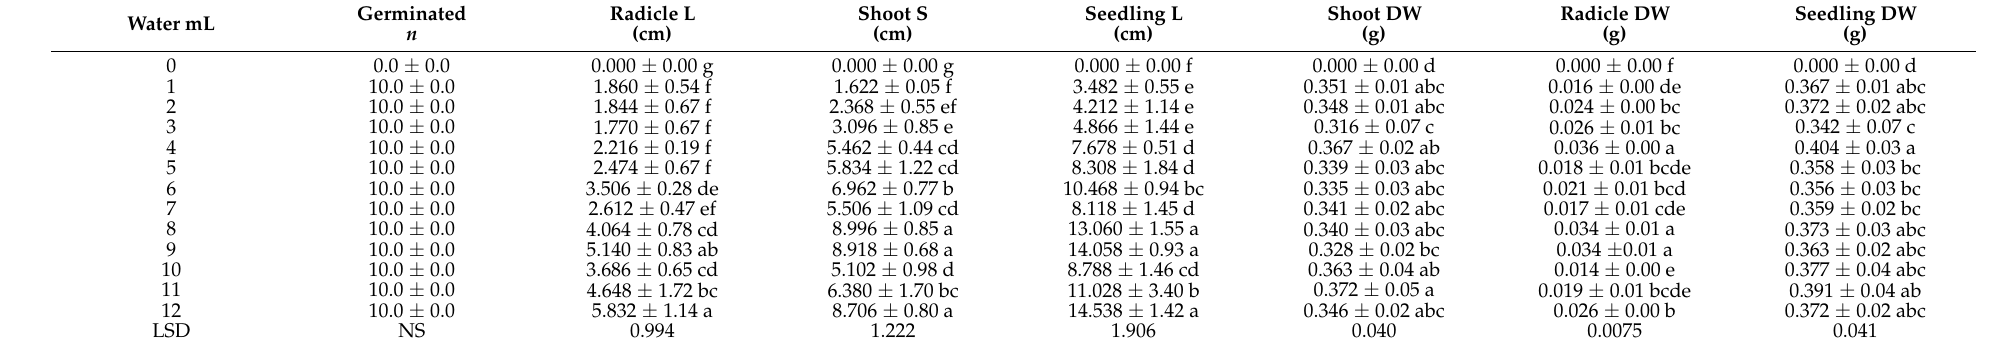
Table 2. Mean values on germination and seedling growth traits for the various amounts of water based on 1 mL intervals.